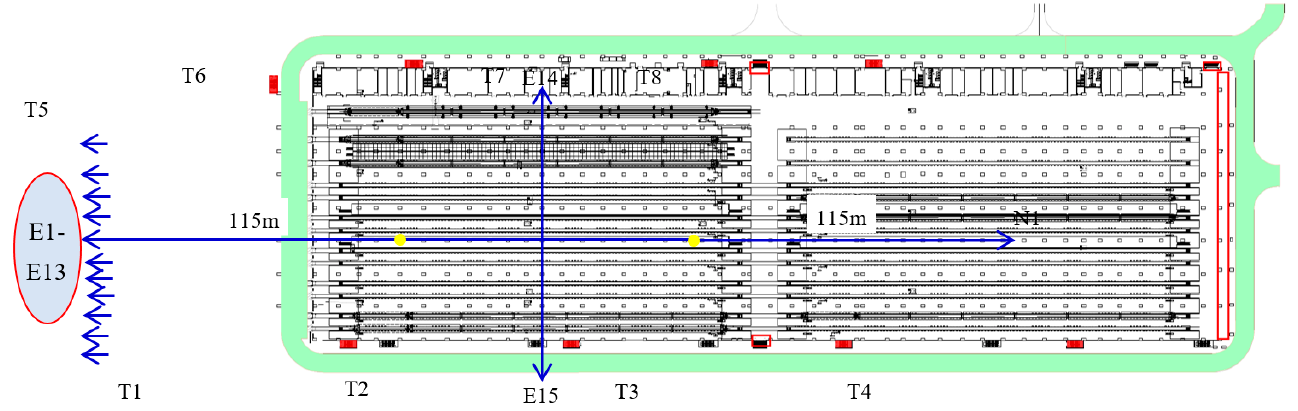
Figure 8. Schematic diagram of the location of the evacuation exits in the use library. Table 7. Statistical diagram of the evacuation width of the application’s library.